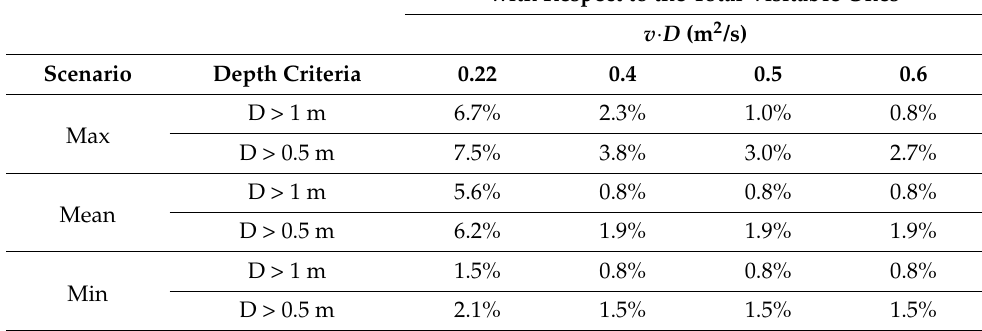
Table 3. Results of hazard assessment regarding human stability in Badalona sewer systems during dry weather conditions. Percentage of visitable conduits with high hazard with respect to the total visitable